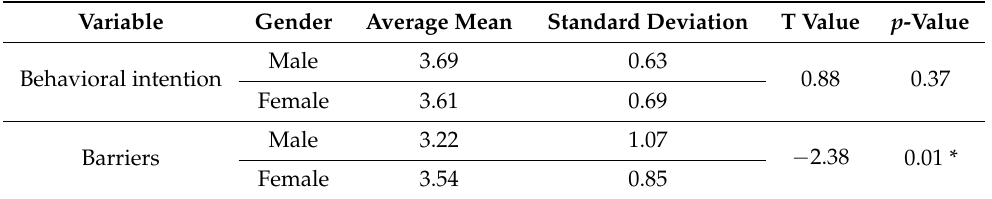
Table 2. Comparison of the differences in behavioral intention and barriers between the medical staff of different genders.